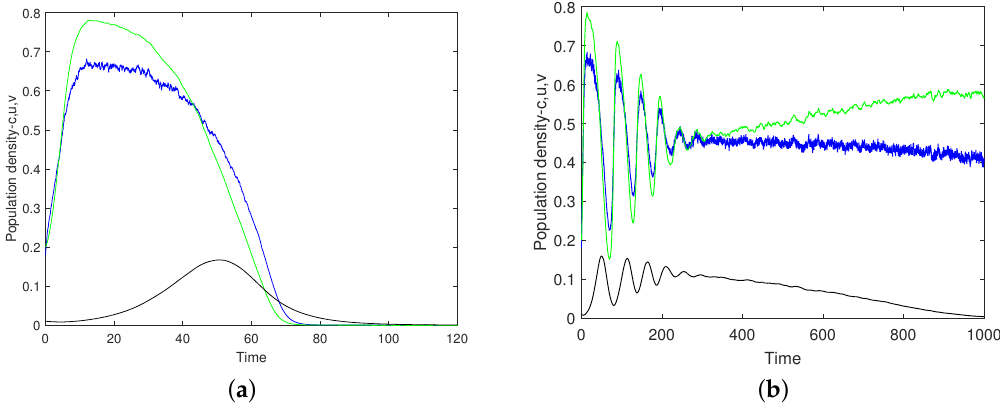
Figure 14. Population densities of phytoplankton (green), zooplankton (black) and the oxygen concentration (blue) vs. time obtained for parameters A D = 0.3, w A = 0.7 · 10 − 6 , A Q = 2.0965, c 1 Q = 0.7, w C = 0 and c 1 D = 0. Results shown in ( a , b ) are obtained in different simulation runs performed for the same parameters and initial